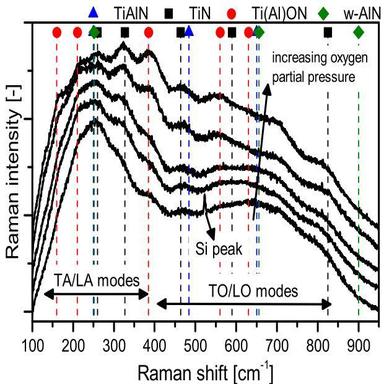
Raman spectra obtained across the graded TiAl(O)N film. The expected positions of peaks of TiAlN, TiN, Ti(Al)ON and wurtzite AlN are indicated as dashed lines.